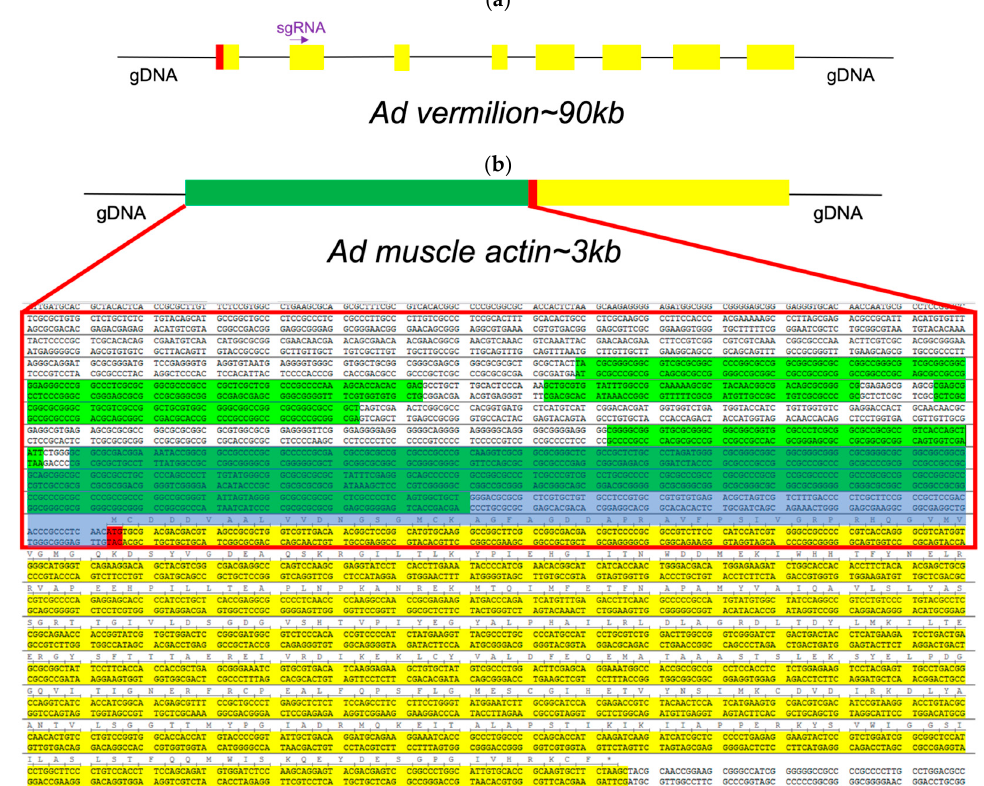
Figure 5. Design of CRISPR target in A. domesticus . ( a ) Schematic of the annotated Ad vermilion gene from A. domesticus genome data. Red box: ATG starting code; Yellow boxes: exons; Purple arrow: sgRNA site. Note: in this figure intron sizes are not proportional to exons; ( b ) Ad muscle actin gene with promoter areas. Red box: Sequences used for promoter prediction; Green sequences: predicted promoters; Red sequences: start codon; Yellow sequences: protein coding area; Gary blue area: promoter sequence used in CRISPR knock-in construct.